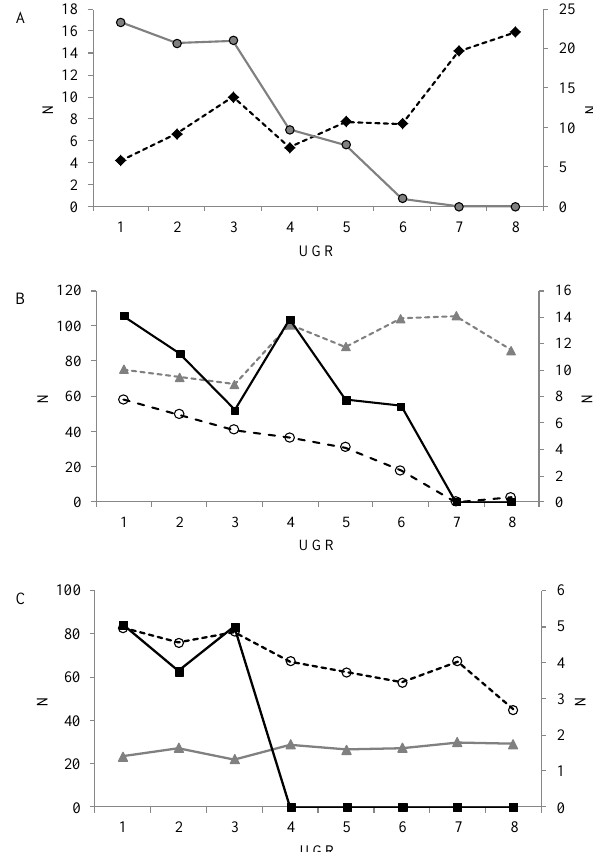
Figure 4. Di ff erent significant trends showed by functional groups belonging to the nesting (A) , habitat (B) , and feeding (C) functional groups in terms of absolute abundance along the eight urbanization gradient rings (1–8 rural to urban gradient). (A) – grey circles and continuous line: ground nesters (T; right y-axis); black rhombuses and dotted line: artificial anthropic cavities nesters (CP; left y-axis). (B) – black squares and continuous line: open forest dwellers (FA) (left y-axis); grey triangles and dotted line: forest dwellers (F; left y-axis); empty circles and black dotted line: open habitat dwellers (A: right y-axis). (C) – black squares and continuous line: predators (P; right y-axis); empty circles and black dotted line: granivorous (G; left y-axis); grey triangles and dotted line: omnivorous (O; left